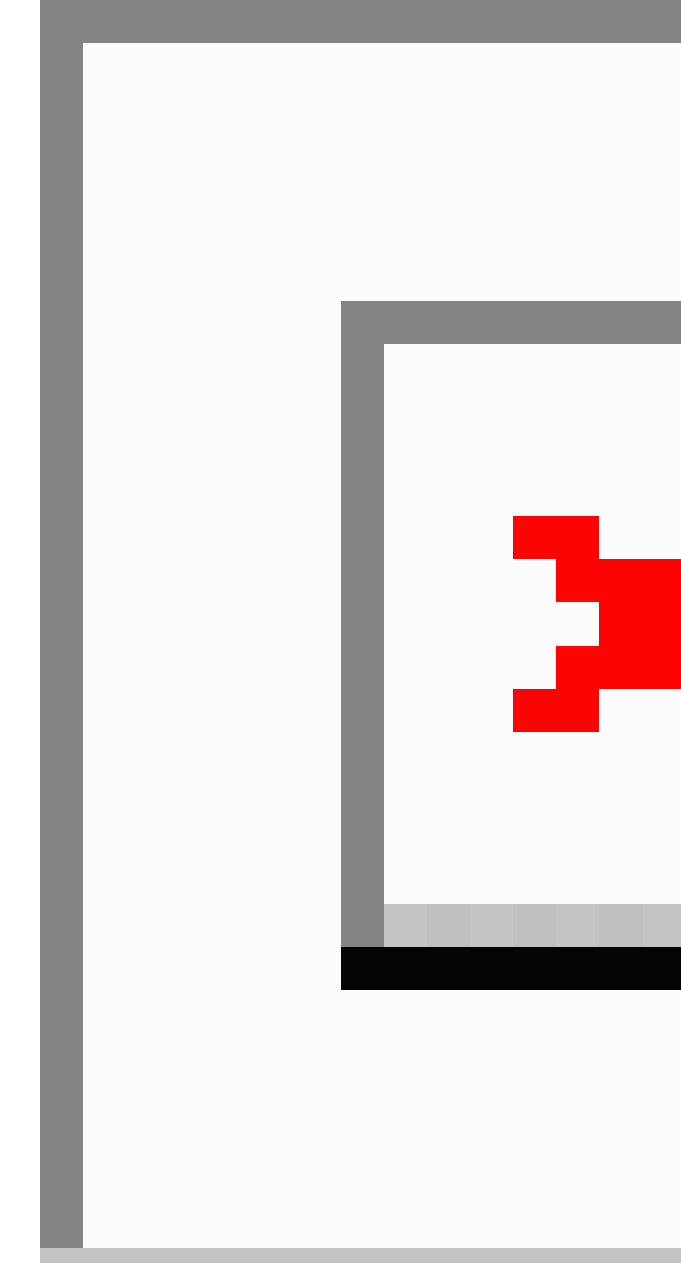
Figure 5. A sample summary sheet: Plan for increasing an